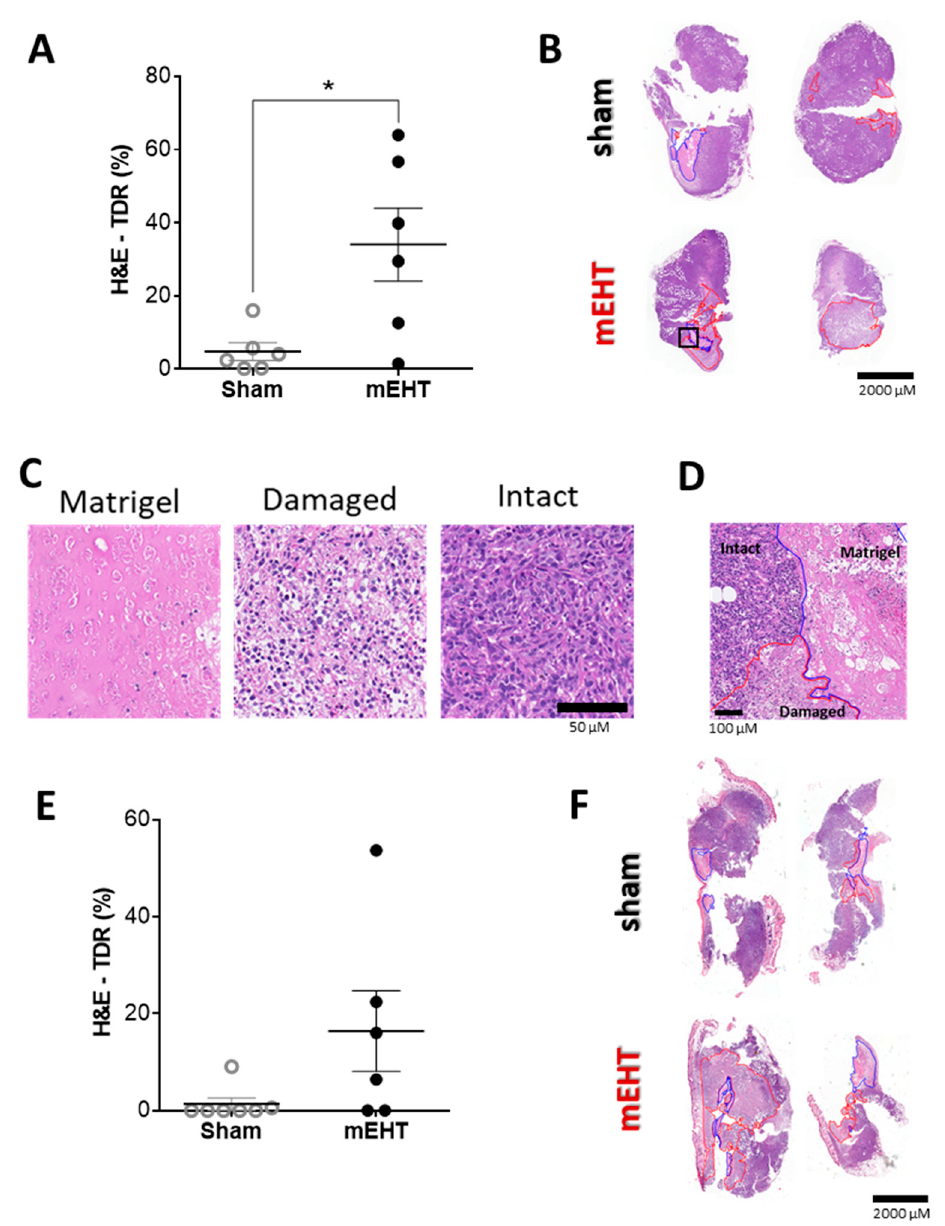
Figure 4. mEHT-induced tumor destruction. ( A , B ) Tumor destruction 24 h after two mEHT treatments. ( A ) Tumor destruction ratio (TDR) evaluated on hematoxylin-eosin (H&E) stained sections; ( B ) Apoptotic areas (red contour) and Matrigel ® (blue contour) on representative H&E stained sections; ( C ) Matrigel ® and damaged tumor areas on H&E stained sections (Magnification: 36×); ( D ) representative image of intact vs. damaged area and Matrigel ® (magnified from the H&E section: B/black rectangle, magnification: 8.5×); ( E – F ) Tumor destruction 24 h after one mEHT treatment; ( E ) TDR evaluated on H&E stainings; ( F ) Apoptotic areas (red contour) and Matrigel (blue contour) on representative H&E stained sections. Mean ± SEM, Mann–Whitney test, n = 6/group, * p = 0.0174.